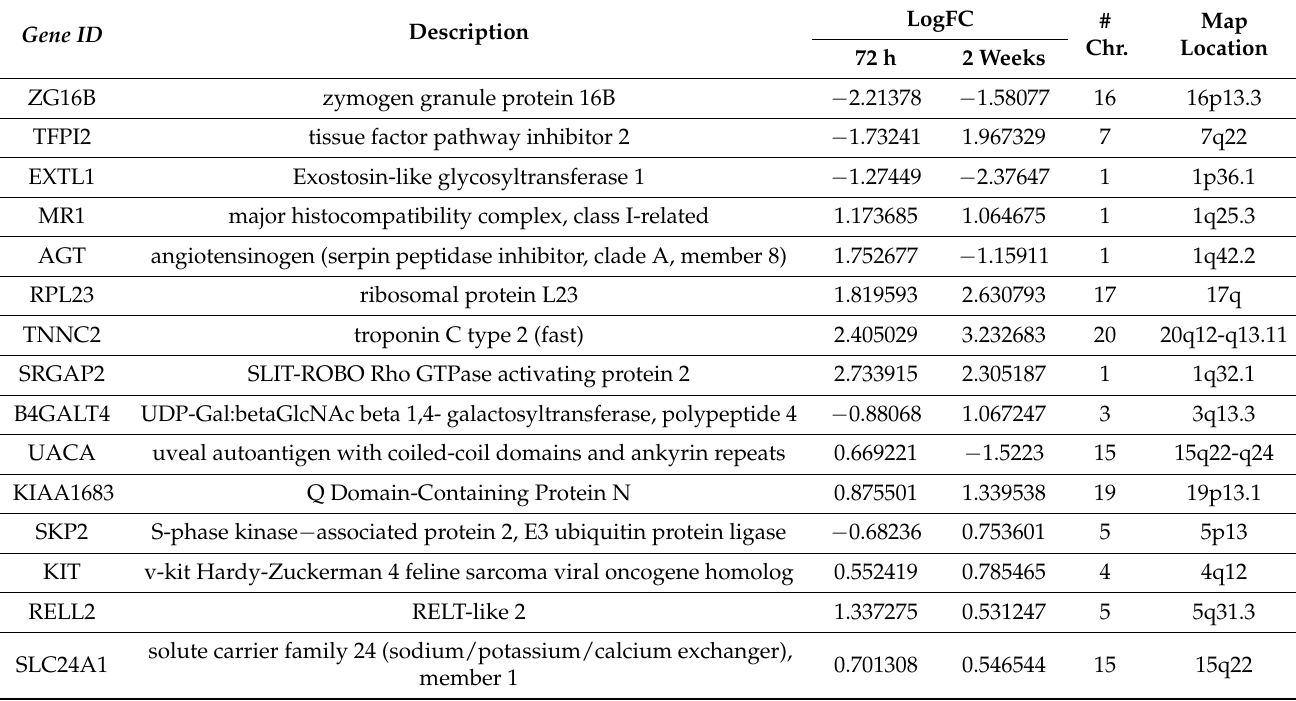
Table 1. List of common deregulated genes shared by IMR90 siCENP-E at 72 h and 2 weeks with relative Log (Fold Change) values (only annotated probes are